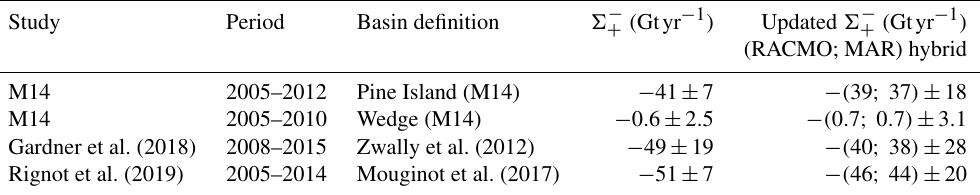
Table 4. Updated mass balance estimates (cid:54) − + for different studies based on hybrid (cid:54) + estimates of this study using complementary (RACMO; MAR) SMB estimates. Indicated periods refer to the considered ice loss processes. Net gain from (cid:54) + is assumed to be stationary during the indicated periods.